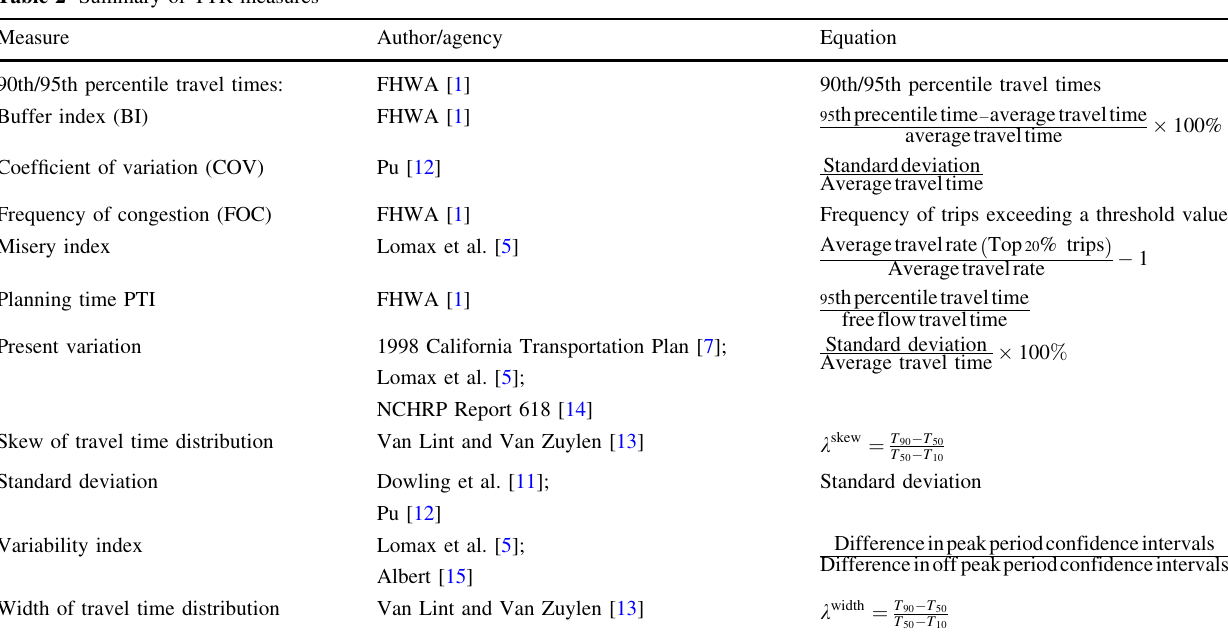
Table 2 Summary of TTR